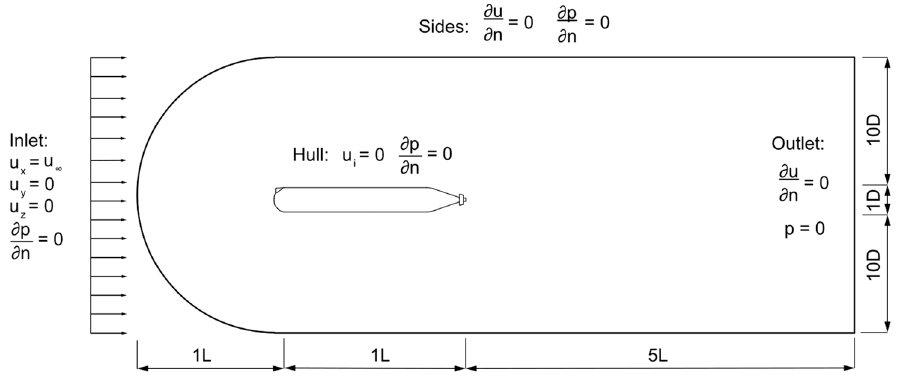
Figure 6. Schematic of the boundary conditions used in the present study.